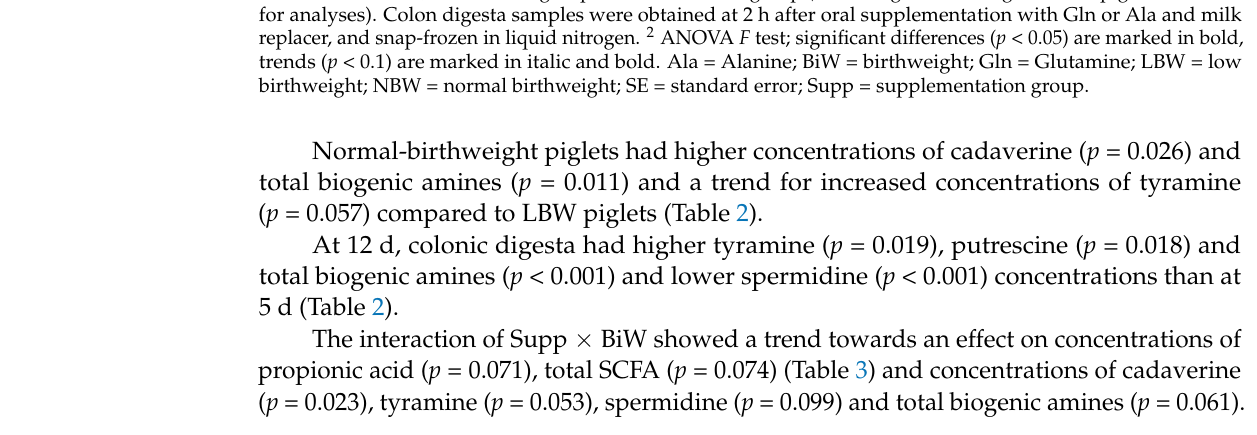
Table 3. Short chain fatty acid concentrations in the colon digesta of 5- and 12-day-old male suckling piglets 1